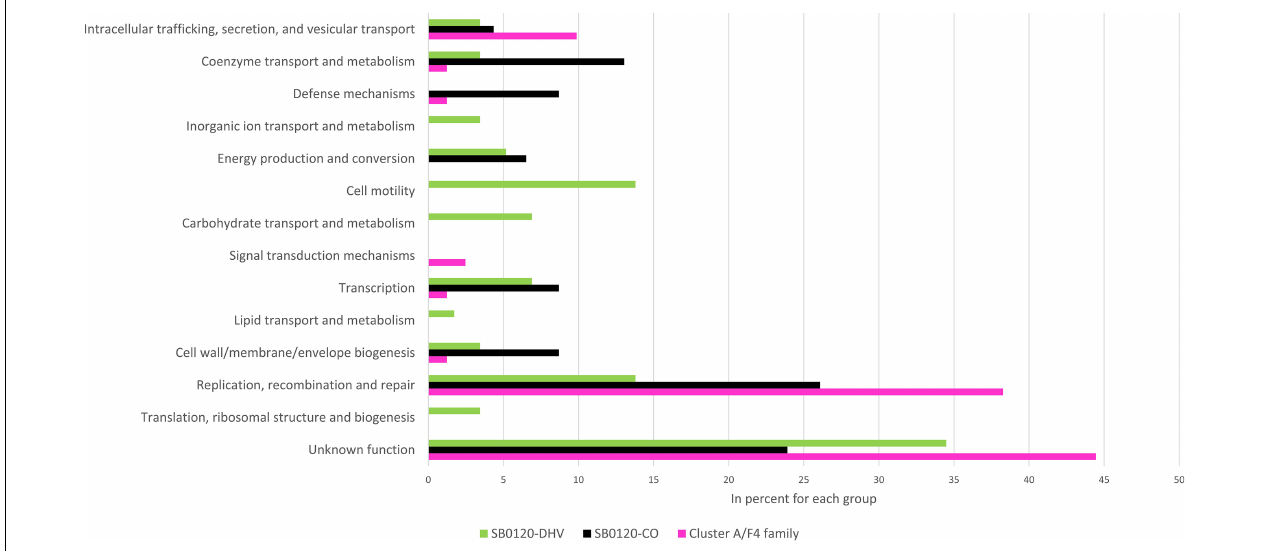
FIGURE 3 | Gene-environment of IS 6110 sites in M. bovis French diversity. Gene Ontology (GO) of coding sequences (CDSs) near IS 6110 sites in 3 M. bovis groups (SB0120-DHV in green, SB0120-CO in black, and Cluster A/F4 family in